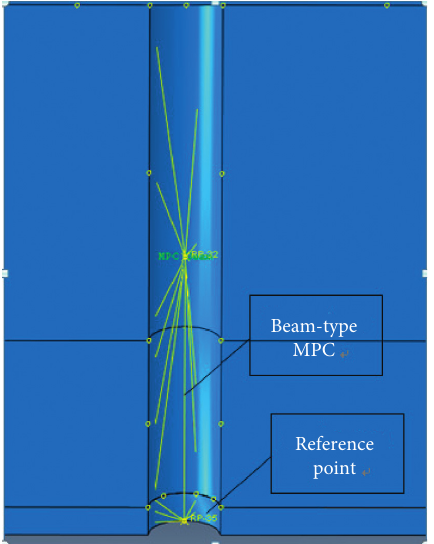
Figure 11: Beam-type multipoint constraint.